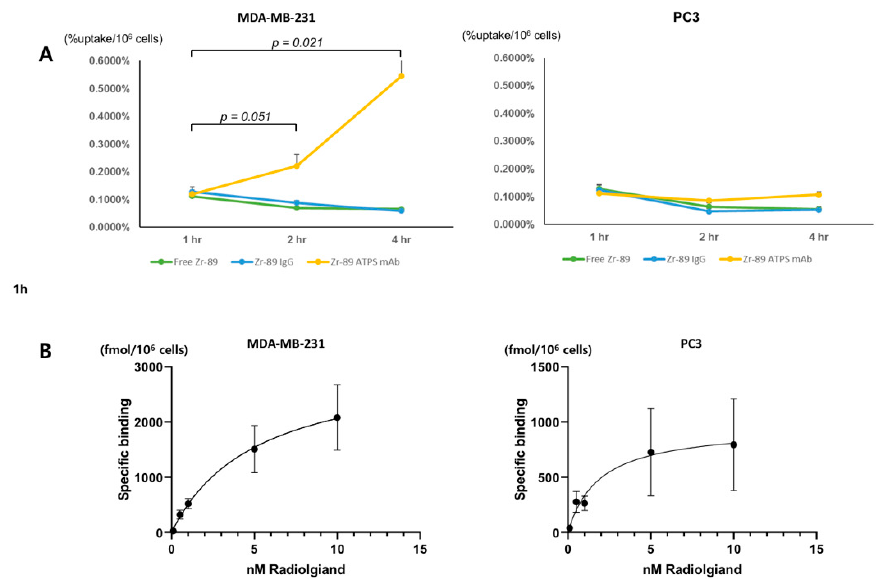
Figure 2. Cellular uptake of Zr-89 ATPS mAb at 1, 2, and 4 h of incubation in MDA-MB-231 and PC3 cells ( A ). The cellular uptake is presented as the percentage of the radioactivity added per 10 6 cells. Saturation binding assay of Zr-89 ATPS mAb in MDA-MB-231 and PC3 cells ( B ). Specific binding is plotted against the radioligand concentrations. ATPS, adenosine triphosphate synthase; mAb, monoclonal antibody. Error bars = standard errors.